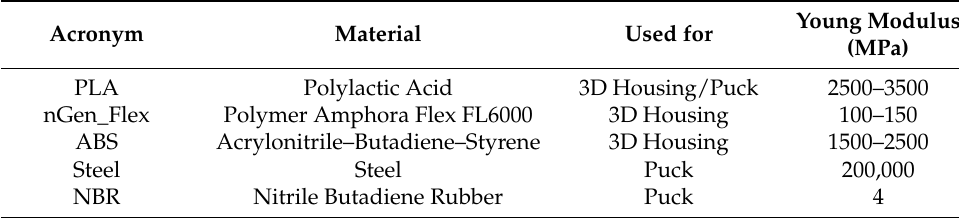
Table 1. Materials used for 3D printing or as